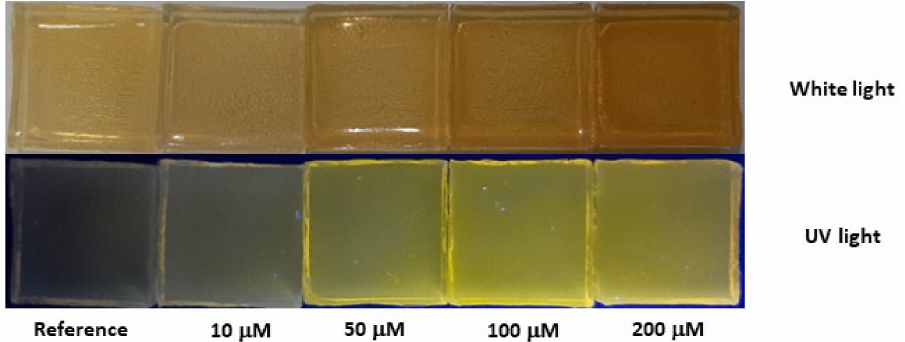
Figure 7. Photographs of colorimetric sensing test with hydrogel Aga-NSCD films after immersion for 2 h in a DI water at different Cu(II)